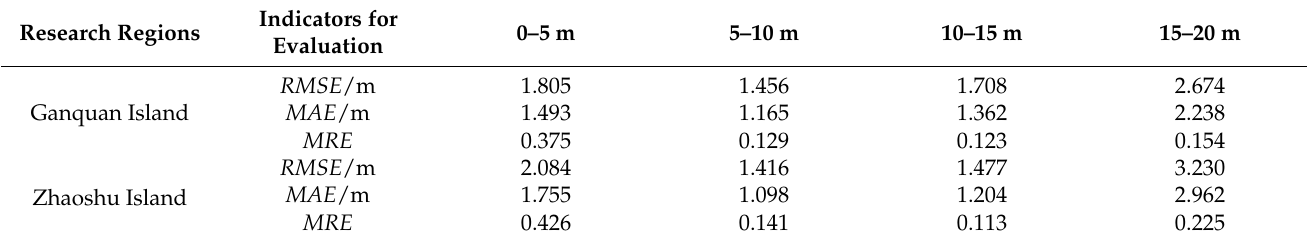
Table 5. Precision evaluation for varying water